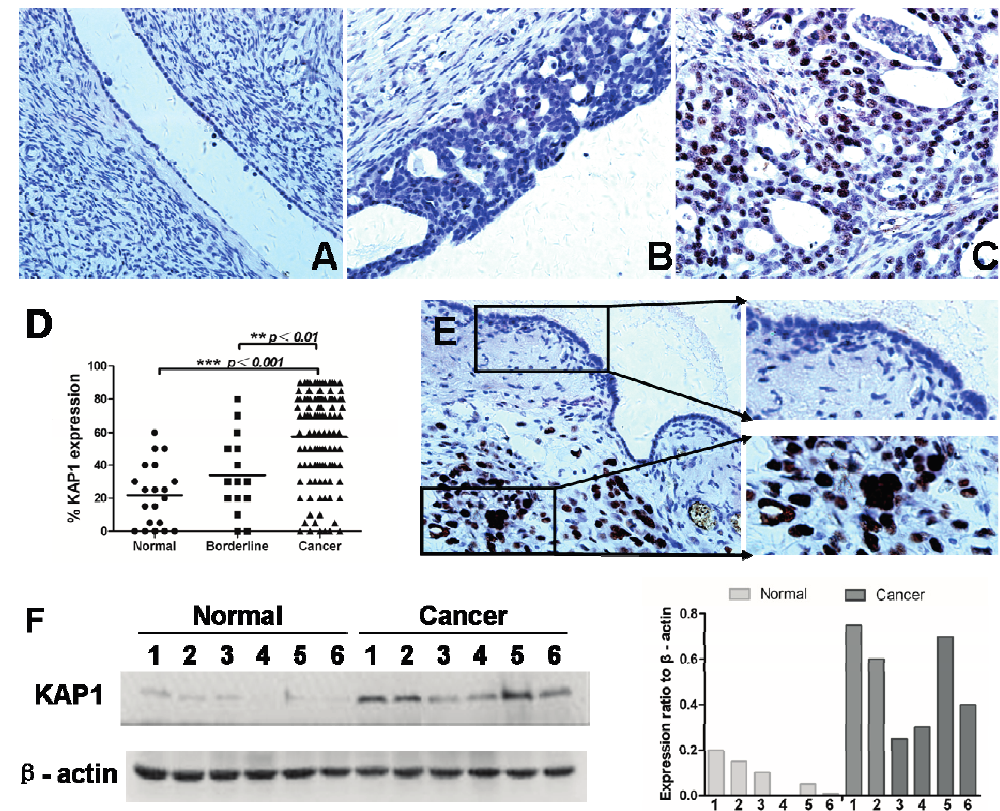
Figure 1. Expression of KAP1 in human non-tumor ovarian tissues and ovarian cancer. ( A ) in normal ovarian tissue; ( B ) in borderline tumor; ( C ) in ovarian cancer; ( D ) KAP1 expression levels in normal ovarian, borderline tumor and ovarian cancer tissues; ( E ) the expression level of KAP1 in non-tumor cells was lower than tumor cells in one sample and ( F ) western blot showed the expression level of KAP1 in cancer tissues was higher than normal ovarian tissues. (IHC, 400×). ( ** p < 0.01; *** p <